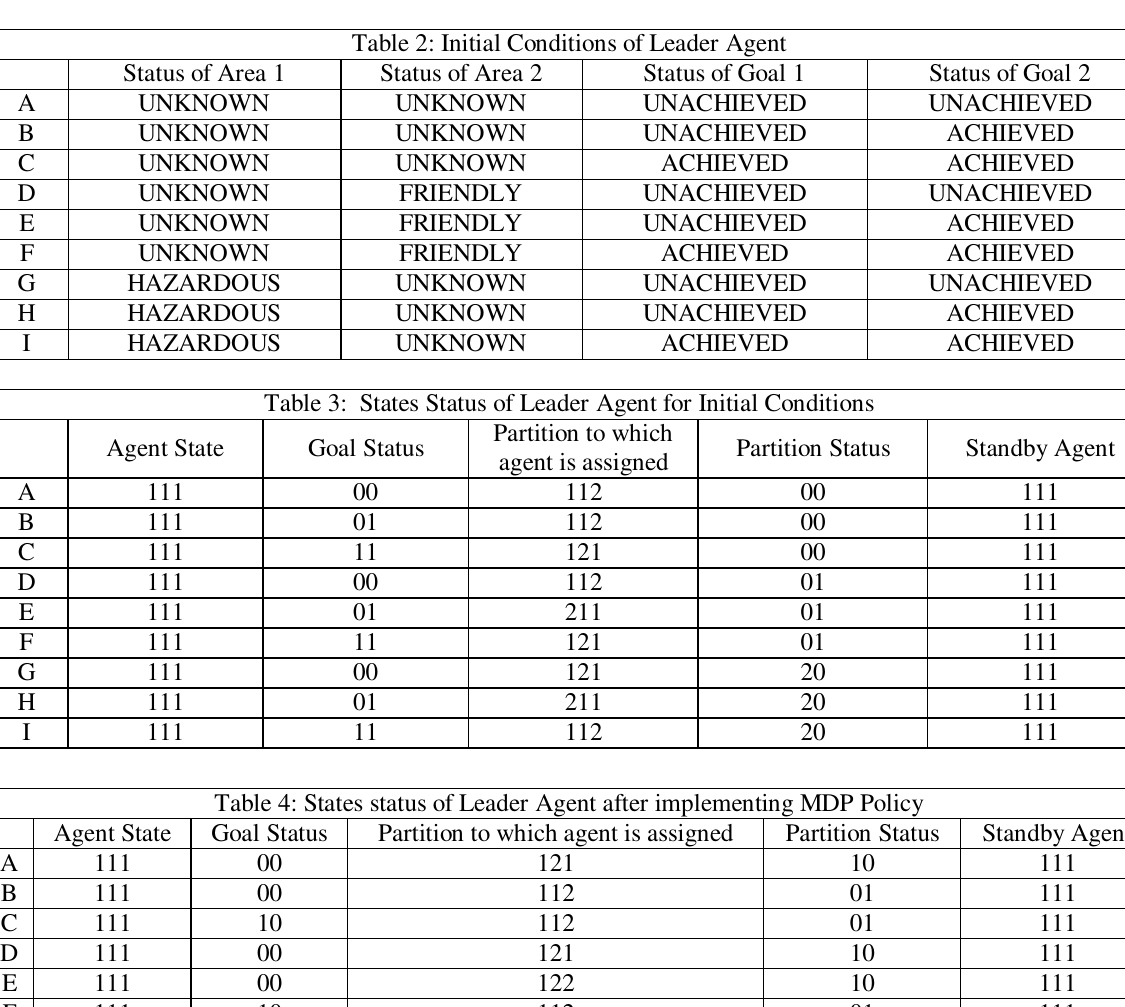
Table 2: Initial Conditions of Leader Agent